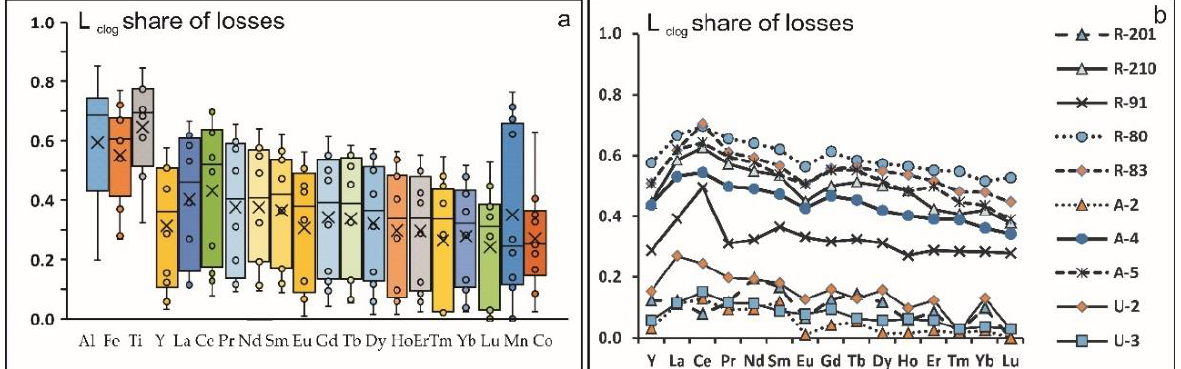
Figure 7. ( a ) Whisker-box plot (max, min, quartiles, med, mean) of the share of losses for the metals susceptible to clogging. ( b ) Decline in the share of losses of REEs for the rivers